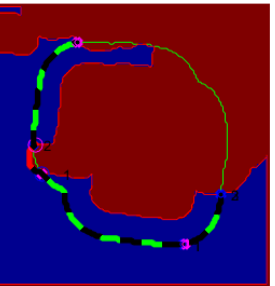
Figure 8. Parts of 𝑝 (green curve) passing through unsafe areas (dark red) are removed. In feasible cases (middle left), the path is rerouted following the border of traversable space 𝑏 (red curve). The final paths on a height level are composed from save segments. Here, a single path is created (bold dashed